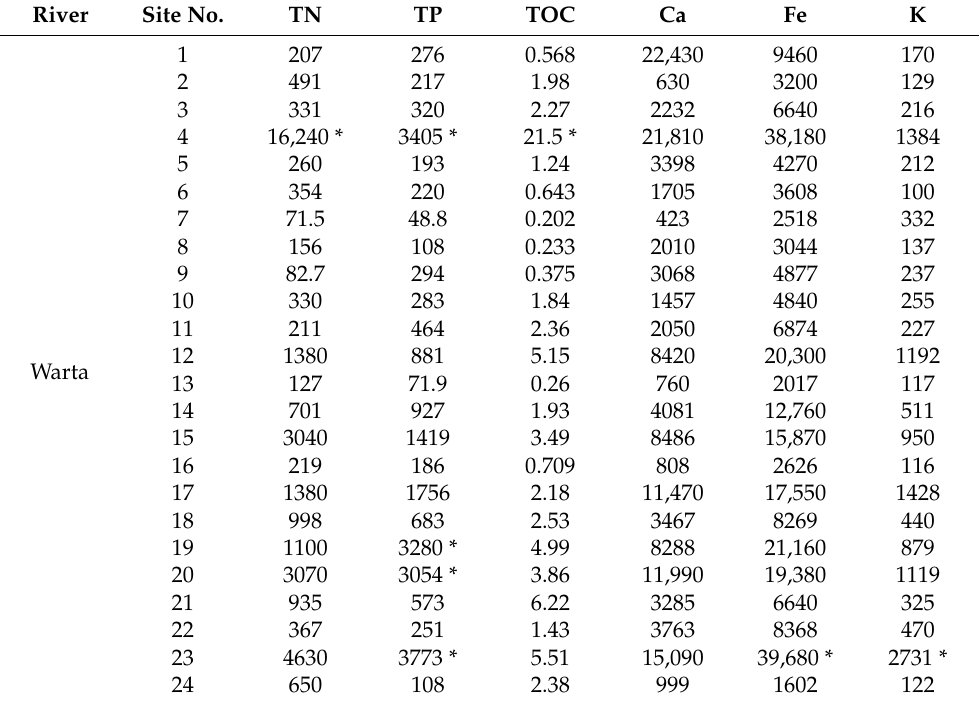
Table A1. Concentrations of chosen elements (mg · kg − 1 ) and TOC (% d.m.) in the bottom sediments of the Warta